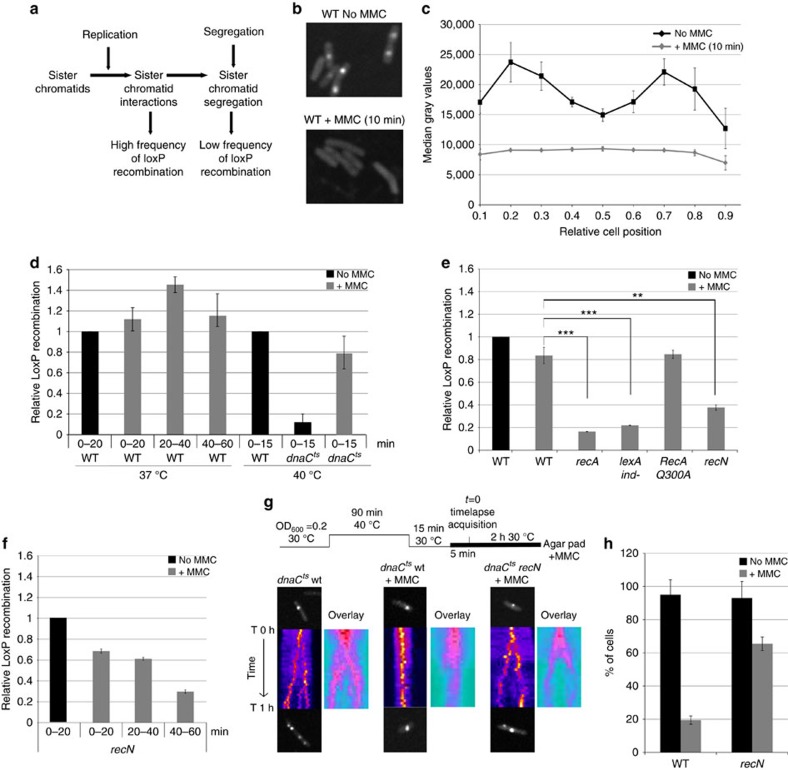
SCIs are preserved in the presence of MMC via a RecN-dependent pathway.(a) The number of SCIs is under the control of replication that produces cohesive sister chromatids and segregation that separates them. (b) MMC causes rapid replication arrest. An MG1655 wild-type strain was used to monitor EdU incorporation in the presence and absence of MMC (10 μg ml−1) for 10 min. (c) Quantification of a 10 min EdU incorporation pulse in WT cells treated or not with MMC. (d) SCIs were estimated at different time points after replication arrest in WT and dnaCts cells treated or not with MMC. SCIs were measured in WT and dnaCts strains by adding arabinose during 20 min pulses after MMC addition. In the dnaCts strain initiation of replication was arrested at 40 °C. (e) Upon MMC treatment, SCIs are dependent on RecA, LexA and RecN. SCIs were estimated using the frequency of loxP/Cre recombination at the ori-3 locus. The results at 40 min are presented; the results at 10, 20 and 30 min are presented in Supplementary Fig. 1. The results are expressed as the relative loxP recombination normalized to the untreated WT strain. Statistical comparisons of histological data were performed using Student's t-test. P values are considered to be significant for α=0.05. *P<0.05, **P<0.01, ***P<0.001. (f) SCIs are not maintained in a recN mutant. MMC was added and SCIs were measured as described in d. (g) MMC prevents sister chromatid segregation in synchronized cells. dnaCts and dnaCts
recN cells tagged with a parSpMT1/ParB-GFP system at ori-3 were synchronized for 90 min at 40 °C, and replication was re-initiated at 30 °C for 10 min. Cells were then placed on an agar pad, with or without MMC, and a time course analysis was performed. The images represent kymographs of a single-cell (fire colour map) and an overlay of about 20 cells (ice colour map). (h) Quantification of segregation events in dnaCts WT and recN strains (100 cells were analysed for each strain). Cells were treated as described in g. Error bars are s.d. of four experiments.